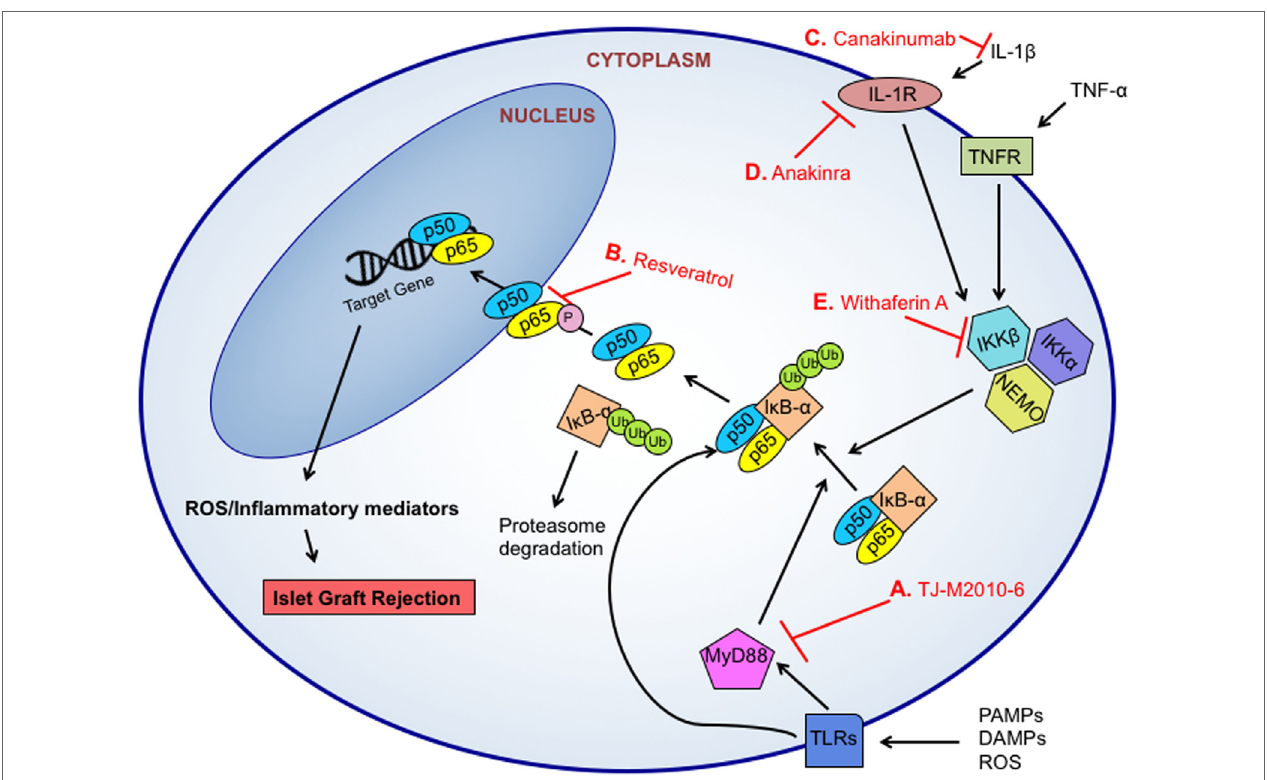
FigURe 2 | Targeted therapeutic approaches for NF- κ B inhibition. NF- κ B can induce the transcription of various inflammatory and oxidative molecules to facilitate islet graft rejection. The NF- κ B pathway can be triggered by pro-inflammatory cytokine signaling, pathogen-associated molecular patterns (PAMPs)-, danger associated molecular patterns (DAMPs)-, or reactive oxygen species (ROS)-initiated toll-like receptor (TLR)-dependent signals. TLR-signaling activates the MyD88-dependent or MyD88-independent signaling pathways, which results in IKK phosphorylation, I κ B- α degradation in the proteasome, and NF- κ B (p50/p65) nuclear translocation. Small molecule inhibitors like TJ-M2010-6 can prevent MyD88 activation and I κ B- α degradation (A) . Resveratrol inhibits the phosphorylation and subsequent nuclear localization of the NF- κ B p65 subunit to prevent transcription (B) . Signaling from cytokines like interleukin 1 beta (IL-1 β ) have been targeted through the use of monoclonal antibodies including anti-IL-1 canakinumab (C) , which blocks binding of IL-1 β to its receptor, and the use of IL-1R antagonist anakinra to block signaling through the receptor (D) . The IKK complex is a target for NF- κ B inhibition. Specifically, inhibition of IKK β and NEMO complex formation by withaferin A can prevent the phosphorylation and release of I κ B- α (e)